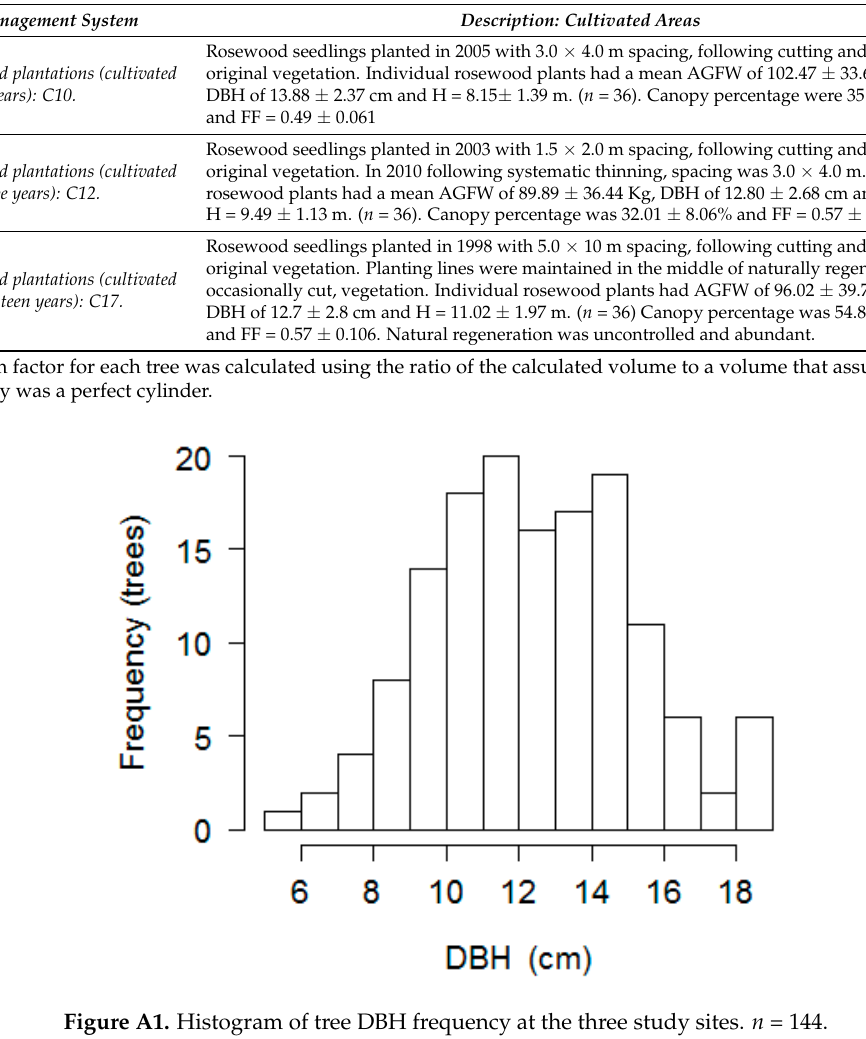
Table A1. Description of study areas showing values for: diameter at breast height (DBH) height (H), above-ground fresh weight of whole tree (AGFW), percentage of canopy fresh weight and form factor